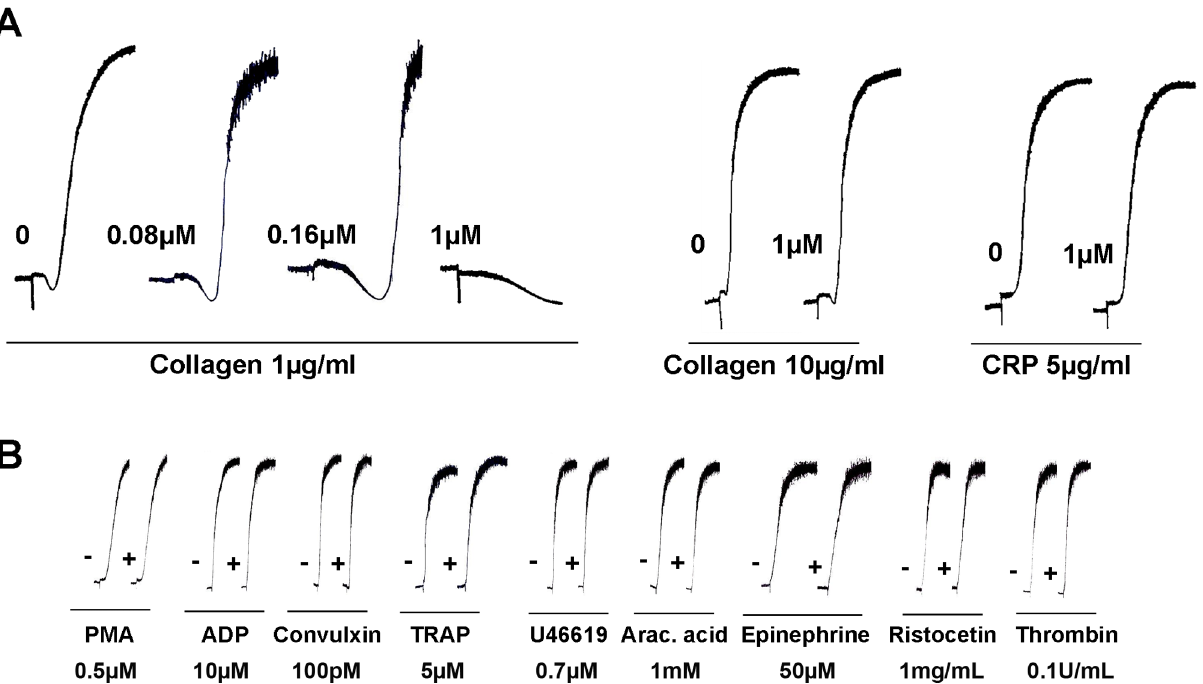
Figure 7. Effect of Simplagrin on platelet aggregation. (A) Human platelet rich plasma from healthy donors was incubated with Simplagrin at different concentrations for two minutes followed by addition of platelet agonists as described under M ETHODS . Platelet aggregation was estimated by turbidimetry under stirring conditions at 37 u C. No effect on collagen induced platelet aggregation was observed at 10 m g/mL of collagen or 5 m g/mL of CRP. (B) Simplagrin (1 m M) shows no inhibitory effect in platelet aggregation induced by other agonists. PMA, phorbol 12-myristate 13-acetate (0.5 m M), ADP (10 m M), convulxin (100 pM), thrombin receptor activating peptide (TRAP) (5 m M), U46619 thromboxane A 2 analog (0.7 m M), arachidonic acid (Ara acid) (1.5 mM), epinephrine (50 m M), ristocetin (1 mg/mL), and thrombin (0.1